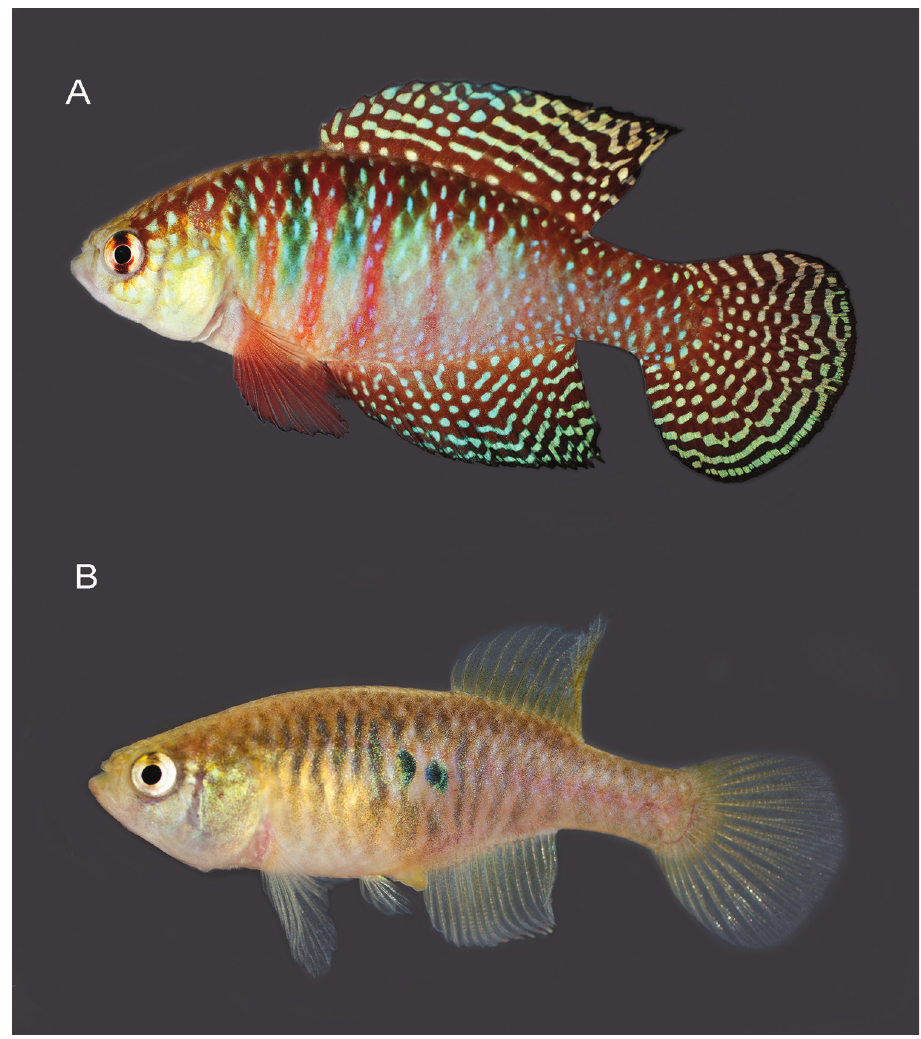
Figure 2. Hypsolebias gardneri sp. n. A live holotype, UFRJ 11859, male, 36.9 mm SL B live paratype, UFRJ 6797, female, 30.0 mm SL. Photographs by WJEM Costa. base of 3 rd and 5 th anal-fin rays in males, reaching base of 1 st anal-fin ray in females; pelvic-fin bases medially united. Dorsal-fin origin at vertical between base of 1 st and 2 nd anal-fin rays in males, between base of 3 rd and 5 th anal-fin rays in females. Dorsal-fin rays 22–24 in males, 15–17 in females; anal-fin rays 21–22 in males, 17–19 in females; caudal-fin rays 23–24; pectoral-fin rays 12–; pelvic-fin rays 5–6. In males, minute papillate contact organs on inner surface three dorsal-most pectoral-fin rays. Second proximal radial of dorsal fin between neural spines of 7 th and 8 th vertebrae in males, between neural spines of 11 th and 12 th vertebrae in females; first proximal radial of